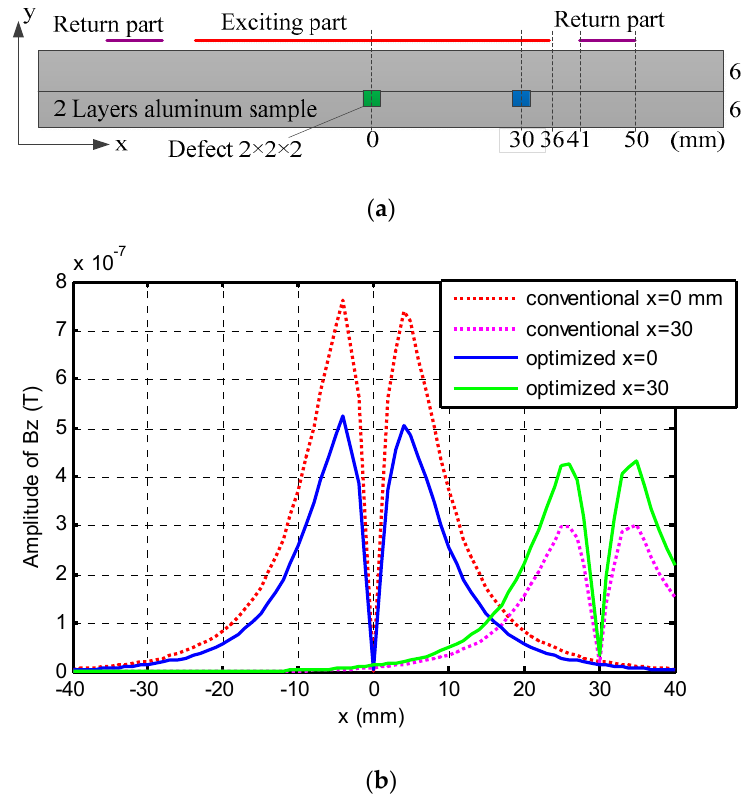
Figure 8. ( a ) Lateral view of tested sample and excitation coil; ( b ) Simulation results of the optimized coil and uniform distribution coil for a defect located at x = 0 mm and x = 30 mm after background subtraction.